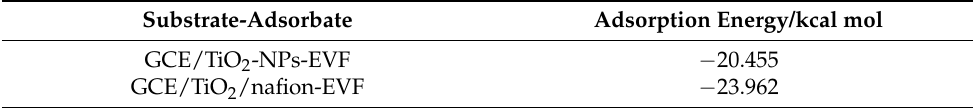
Table 1. Calculated adsorption energy for the substrate-adsorbate systems.